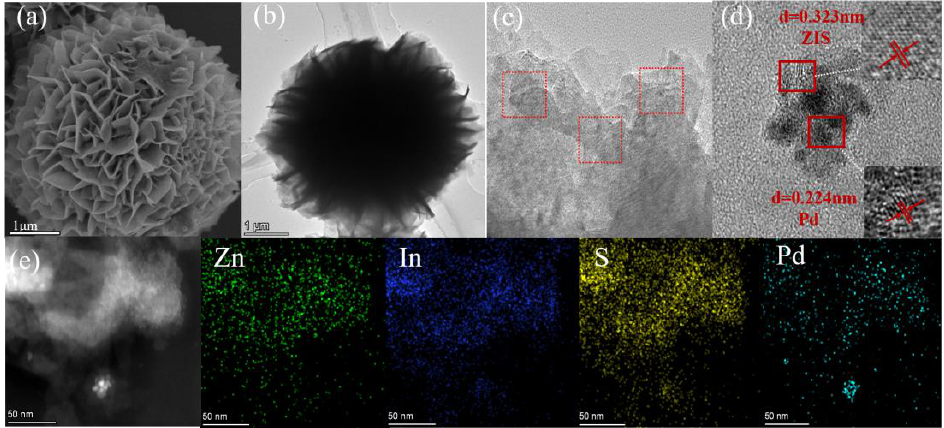
Figure 2. ( a ) SEM of ZIS; ( b, c ) TEM of 1% Pd/ZIS; ( d ) HRTEM of 1% Pd/ZIS; ( e ) HAADF-TEM and corresponding elemental mapping images Zn, In, S, Pd. corresponding elemental mapping images Zn, In, S,